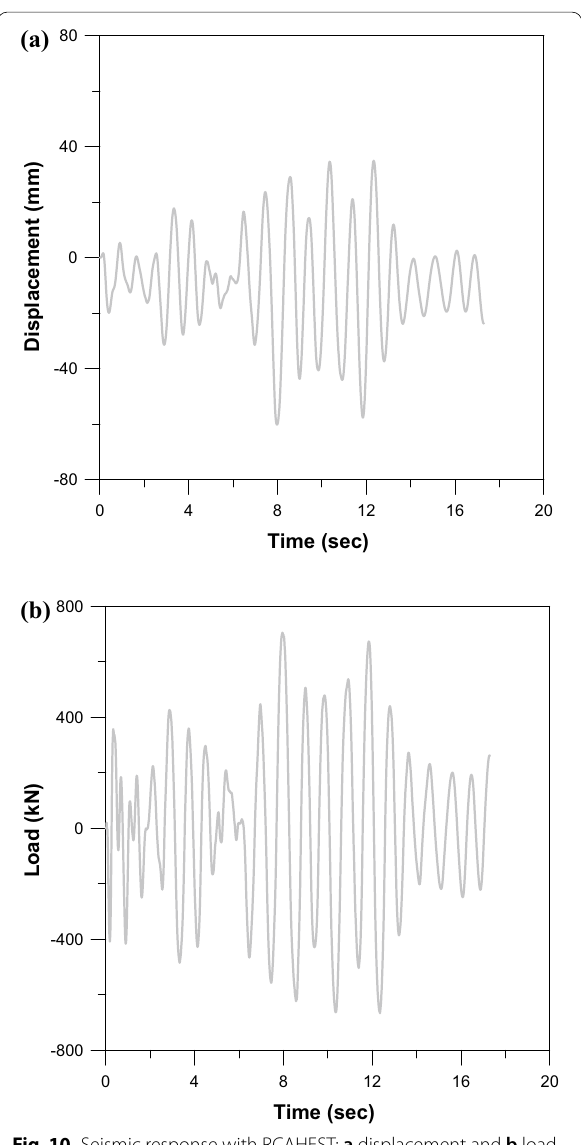
Figs. 14 and 15 show that the Case-1 and Case-1D provided better seismic performance than the Case- 2, Case-2D, Case-3, and Case-3D. Fig. 16 also shows that the Case-1, Case-2, and Case-3 provided better seismic performance than the Case-1D, Case-2D, and Case-3D. Tables 3 and 4 also show the evolution of the